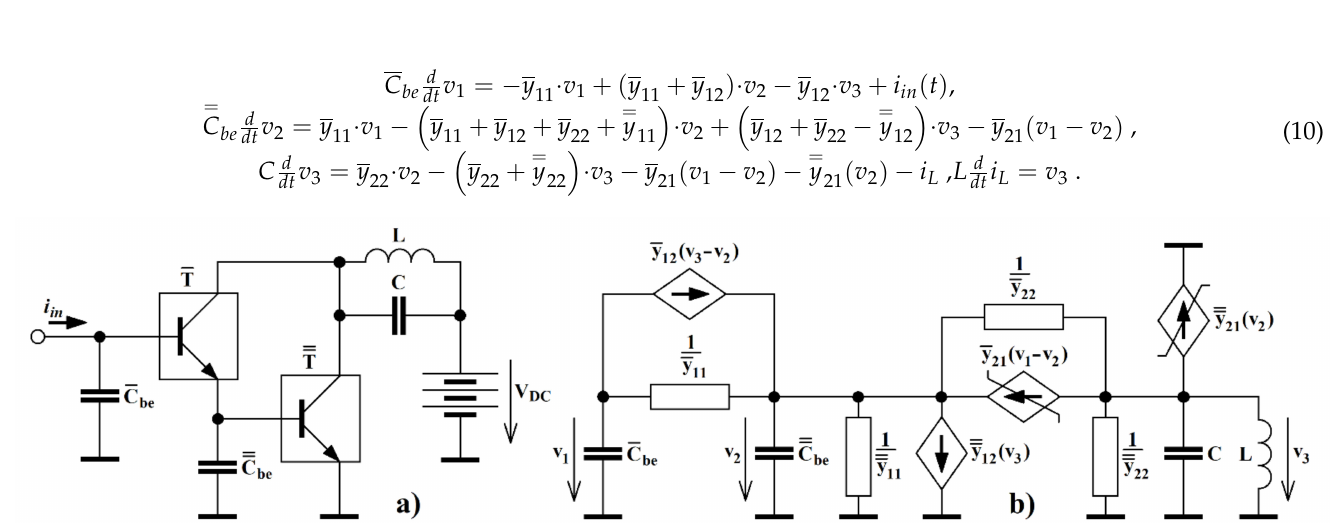
Figure 2. Simplified schematic of analyzed networks: ( a ) concept of driven resonant Darlington’s stage with non-ideal GBT (non-integrated, discrete form of implementation), ( b ) isolated circuit with equivalent models of generalized